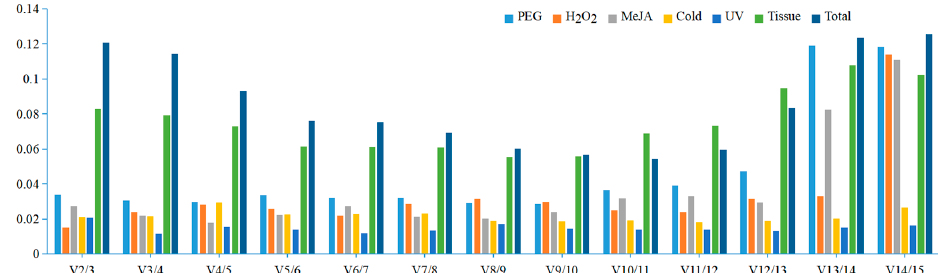
Figure 5. The pairwise variation values (Vn/Vn + 1) of all candidates calculated using the geNorm to confirm the optimal number of reference genes for qPCR data accurate normalization; the threshold used was 0.15, below which the inclusion of an additional reference gene is not necessary.